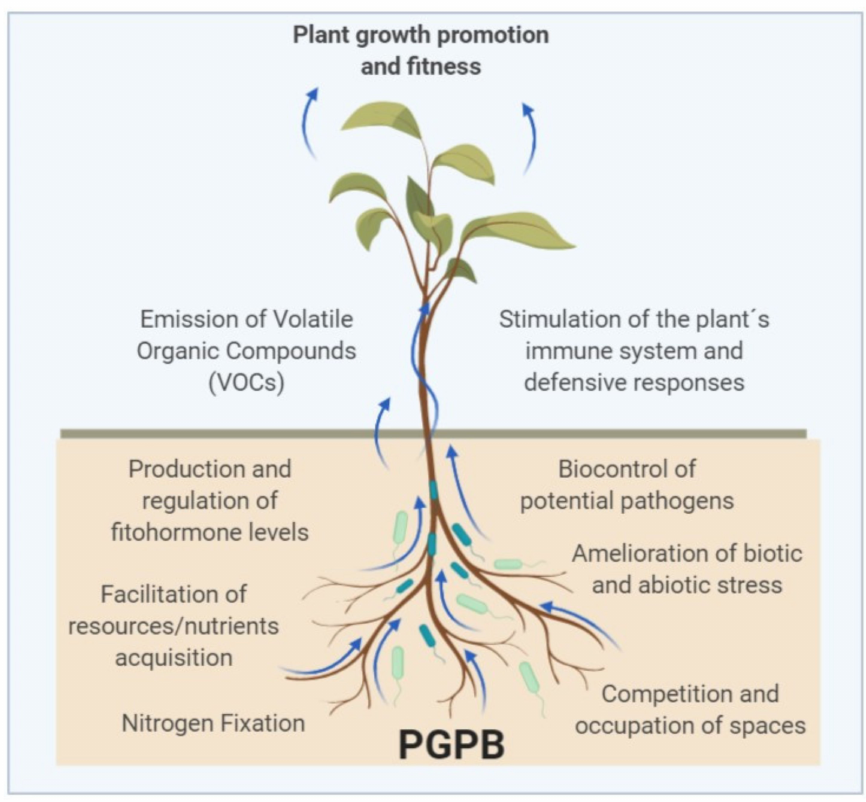
Figure 1. Beneficial mechanisms exerted by plant growth-promoting bacteria (PGPB) to stimulate healthy plant growth and